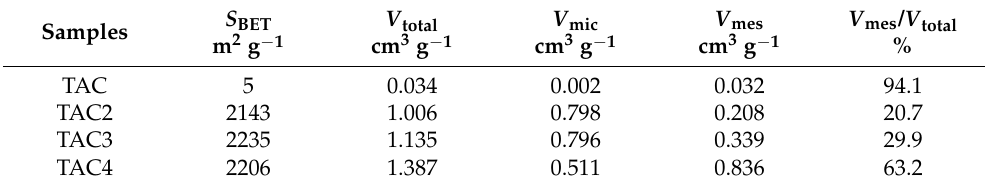
Table 1. Textural characteristics of the activated carbons.